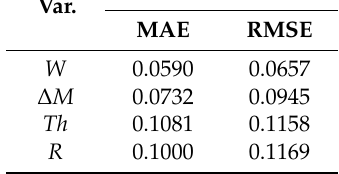
Table 9. Predicted error criteria results using the regression model: testing analyses.